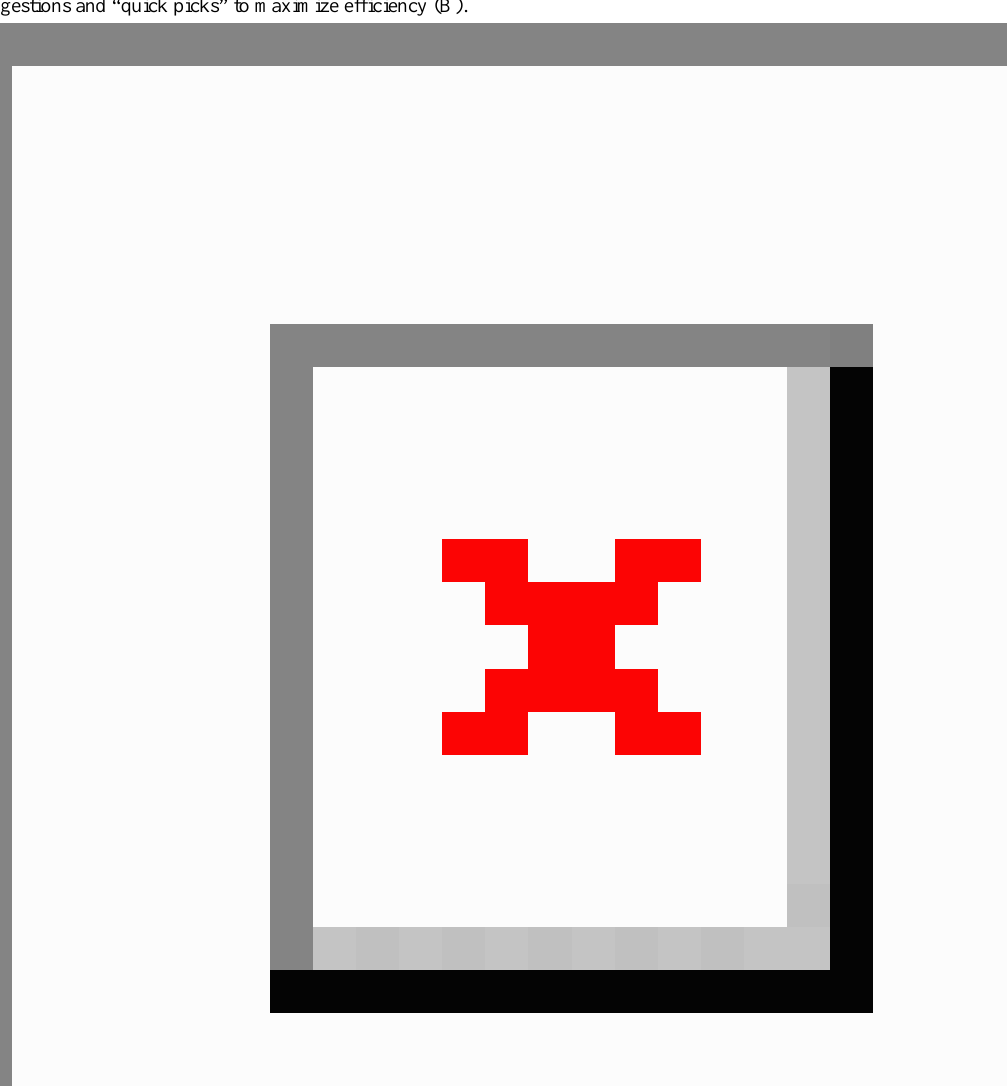
Figure 2. The clinical GPS v2.0 (cGPS) Web-based tool takes clinicians through an 8-step process that supports natural language entry (A) and uses autosuggestions and “quick picks” to maximize efficiency